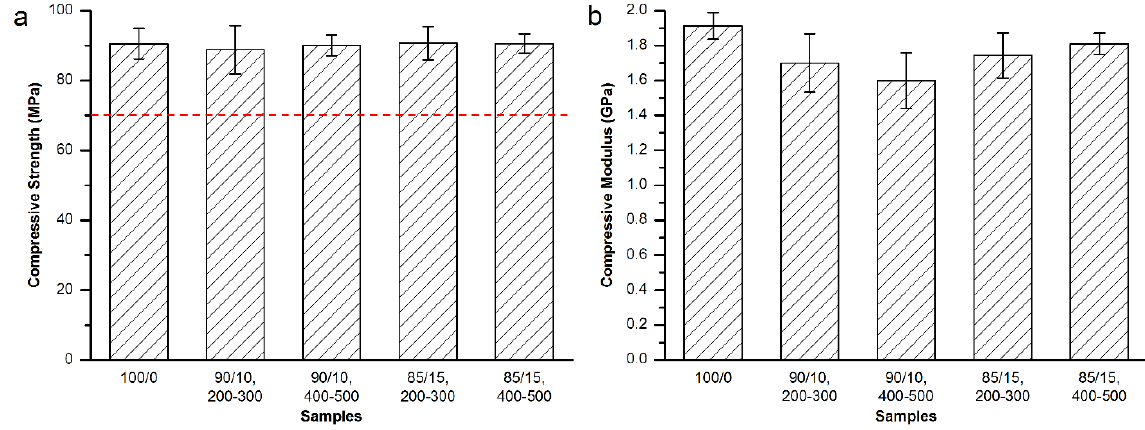
Figure 3. ( a ) Compressive strength and ( b ) compressive modulus of 200–300 μ m and 300–400 μ m MC particles modified Osteopal ® V.